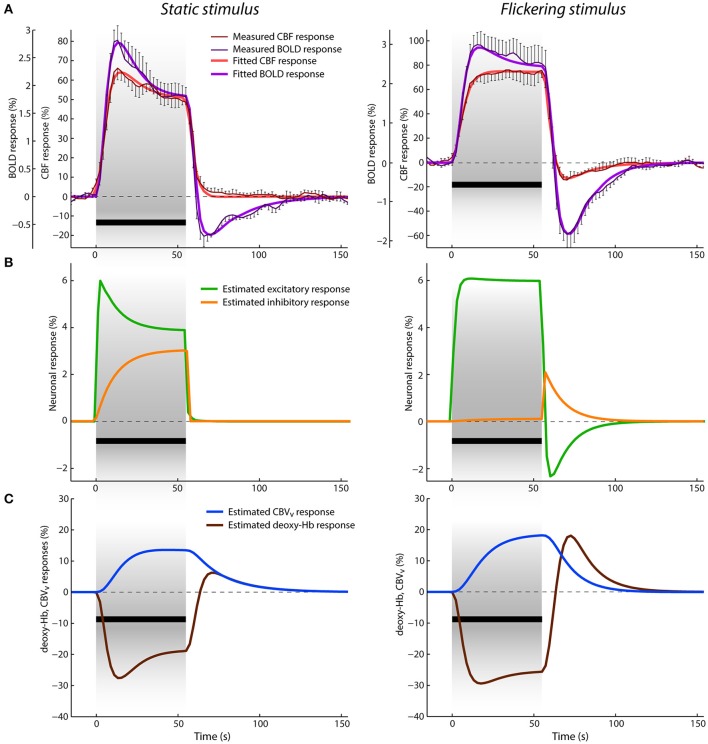
Data and results depiction of experiment I. (A) The average CBF and BOLD responses derived from the ASL data for static (left) and flickering (right) conditions displayed in percent signal change with thin dark red and purple lines, respectively. The error-bars represents the standard error of the measurement (n = 5). The measured responses are overlaid with the fitted CBF and BOLD responses, displayed with thick red and purple lines. The black bar below the responses represents the stimulation period. (B) Estimated excitatory (green lines) and inhibitory (orange lines) responses in percent signal change. (C) Estimated venous CBV (blue lines) and deoxyhemoglobin content (brown lines) responses in percent signal change.